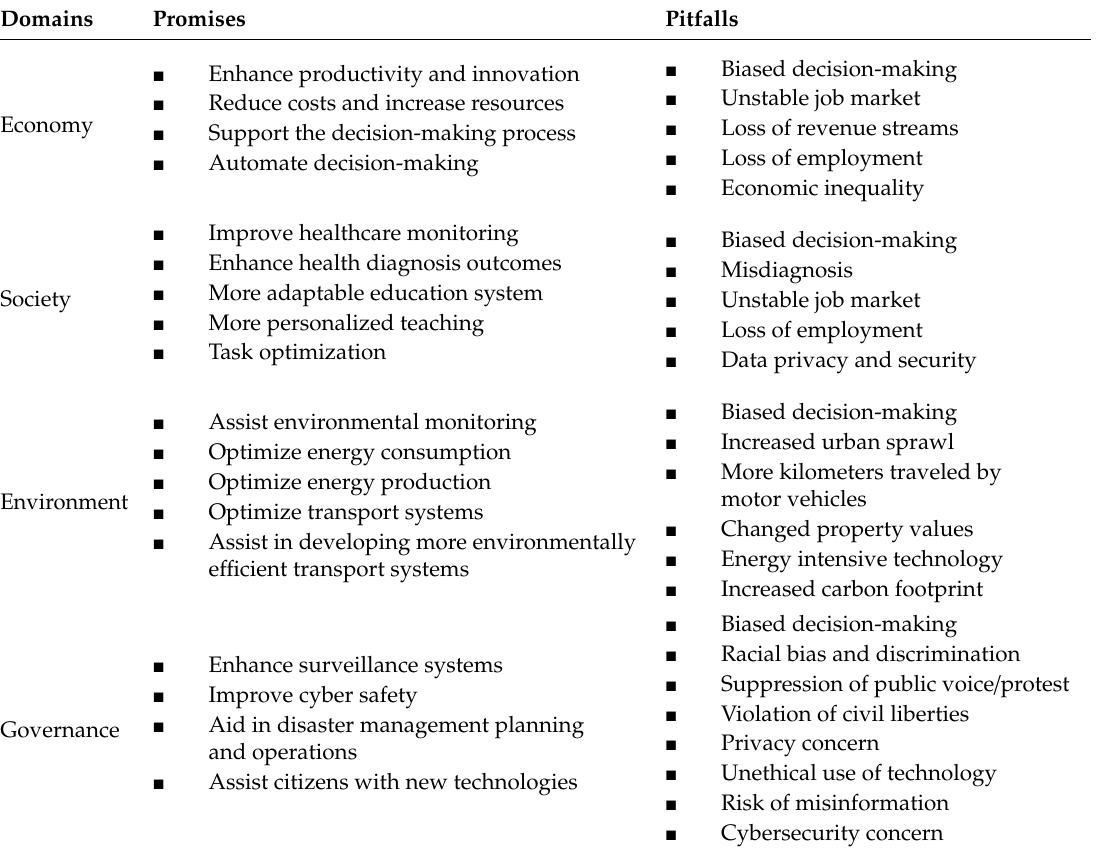
Table 4. Promises and pitfalls of AI for cities, derived from Yigitcanlar et al.